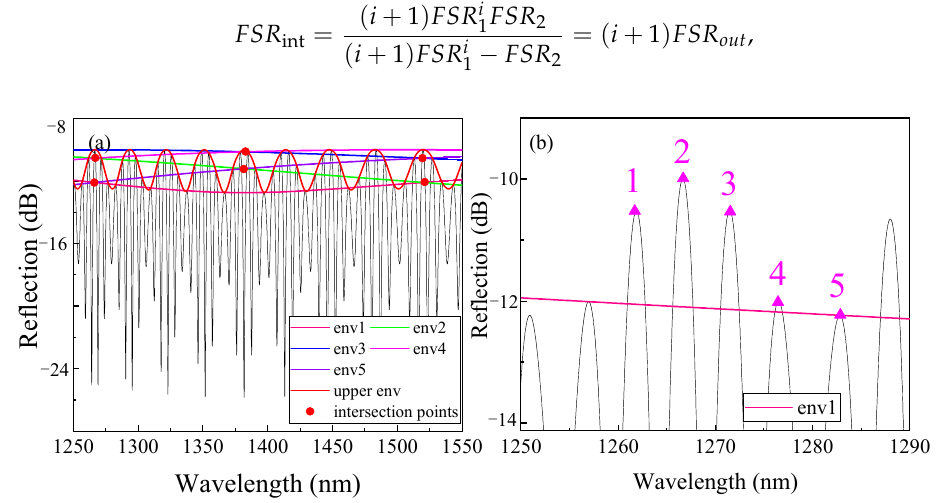
Figure 4. Simulated spectra of the HEV. ( a ) The spectra of FP1, FP2, and cascaded HVE FPI at i = 4 and ( b ) locally amplified spectra with spaced points.